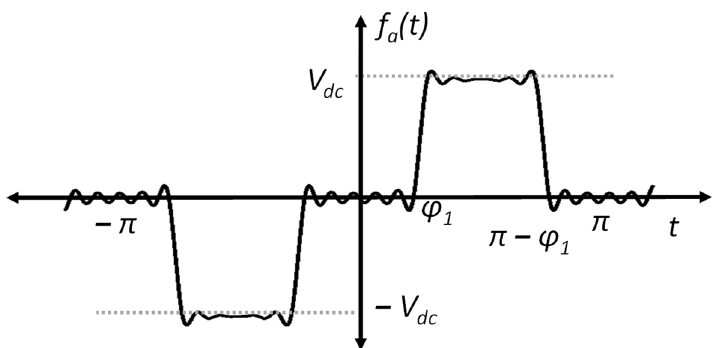
Figure 4. 3-level approximated waveform.